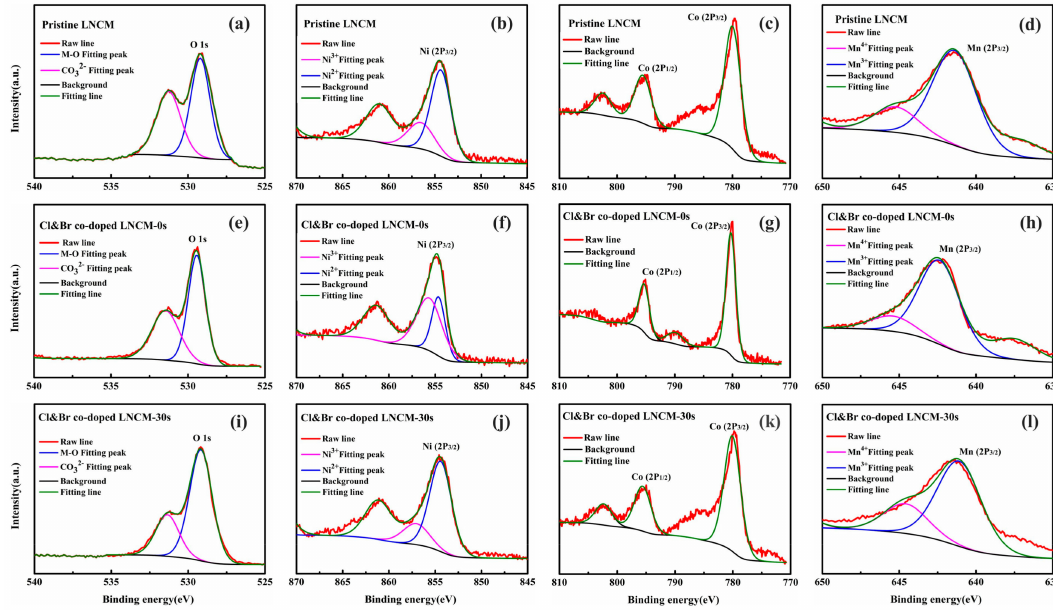
Figure 3. XPS spectra of ( a ) O 1s, ( b ) Ni 2p 3/2 , ( c ) Co 2 p 3/2 , ( d ) Mn 2p 3/2 for Pristine LNCM; ( e ) O 1s, ( f ) Ni 2p 3/2 , ( g ) Co 2p 3/2 , ( h ) Mn 2p 3/2 for Cl&Br co-doped LNCM; ( i ) O 1s, ( j ) Ni 2p 3/2 , ( k ) Co 2p 3/2